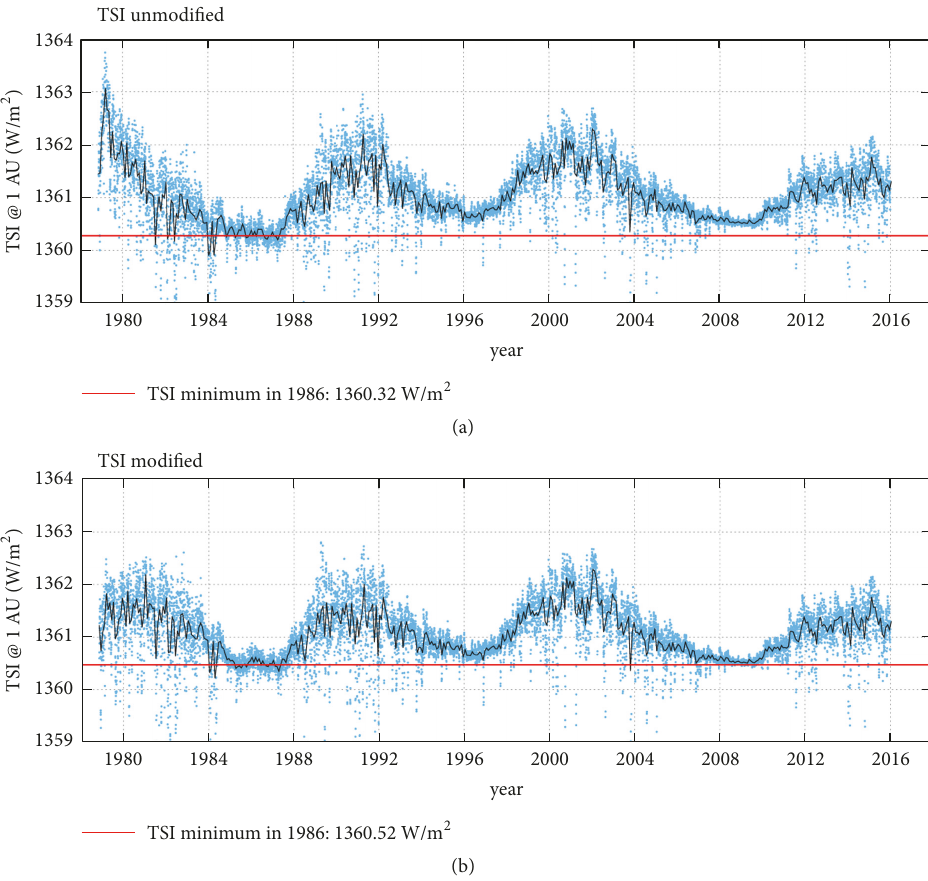
Figure 4: TSI composites proposed by Dudok de Wit et al. [9]. (a) Using the original published TSI satellite data. (b) Using the TSI satellite data modified by PMOD. Daily values (blue), monthly mean